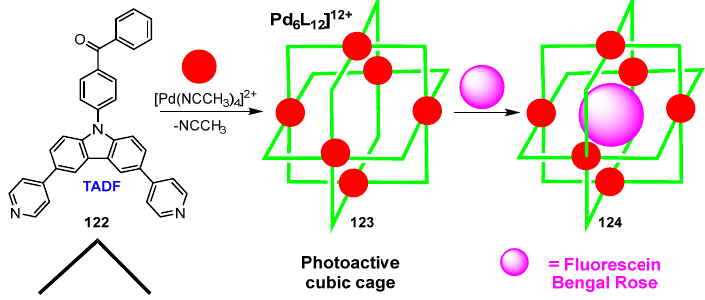
Figure 34. Schematic representation of the synthesis and structure of cubic cage Pd 6 L 12 123 and formation of host-guest complexes 124 with fl uoresceine or Bengal Rose. Adapted from [111].